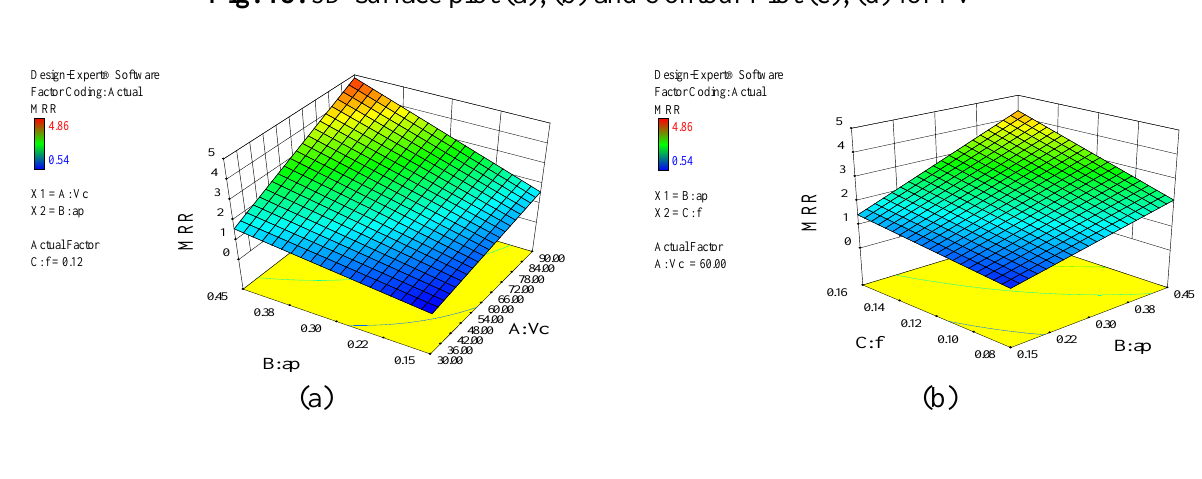
Fig. 15. 3D surface plot (a), (b) and Contour Plot (c), (d) for